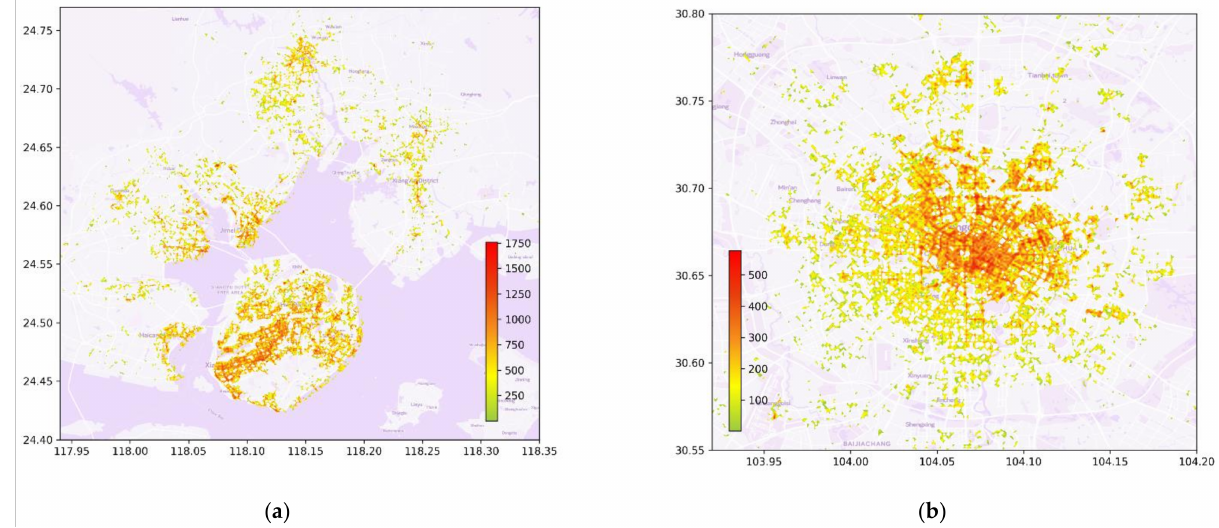
Figure 3. ( a ) Xiamen car-hailing order heat map; ( b ) Chengdu taxi order heat